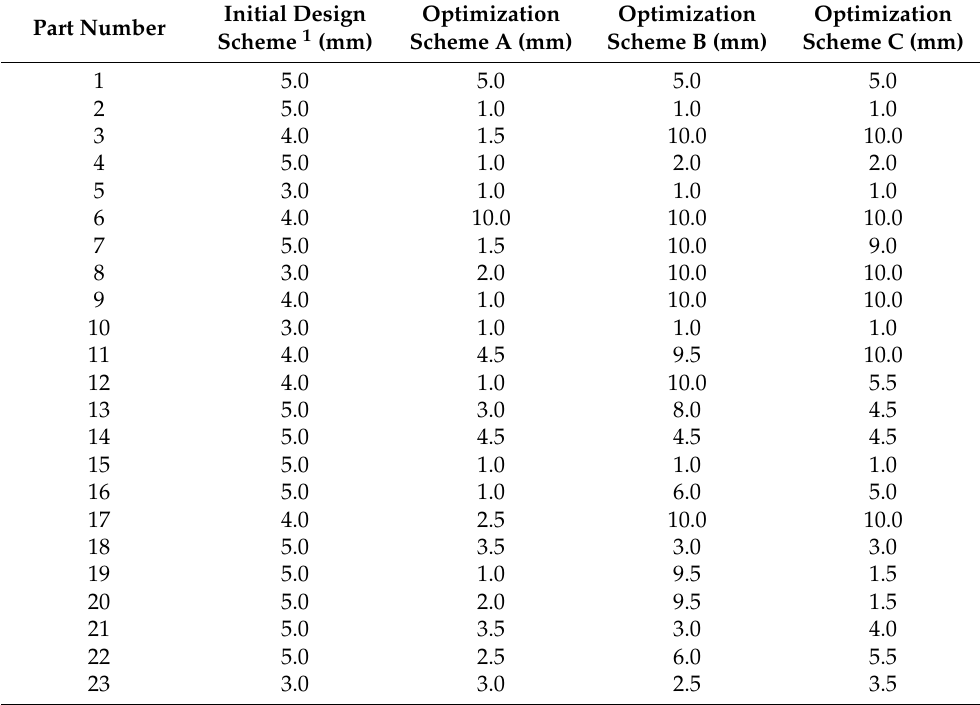
Table 5. The thickness of the truss structure parts.